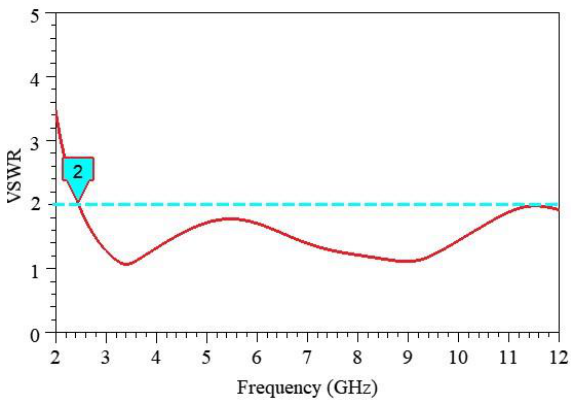
Fig. 5. VSWR verses Frequency of HMSA